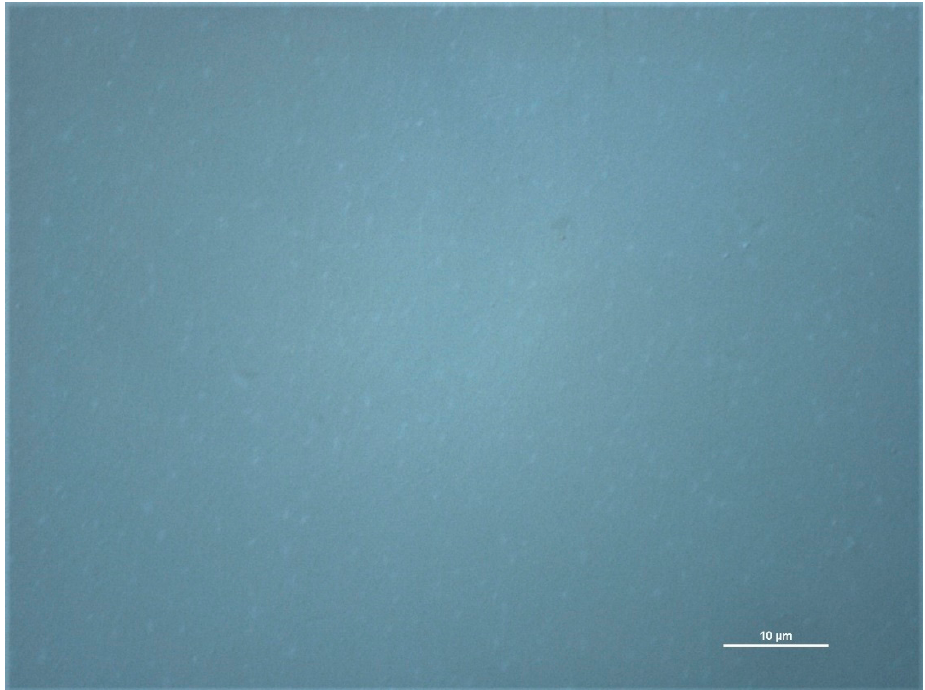
Figure 2. Optical image of graphene layer transferred onto glass substrate. Scale bar is 10 μ m.